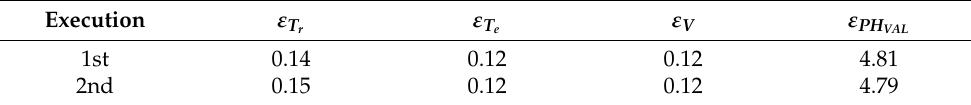
Table 2. Statistics for M 1